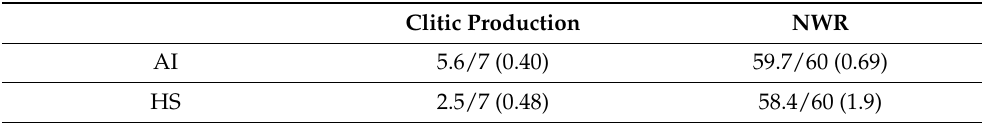
Table 3. Raw scores means and (standard deviations) for the DO clitic production and the NonWord Repetition (NWR) for both Heritage Speakers (HS) and Adult Immigrants (AI).